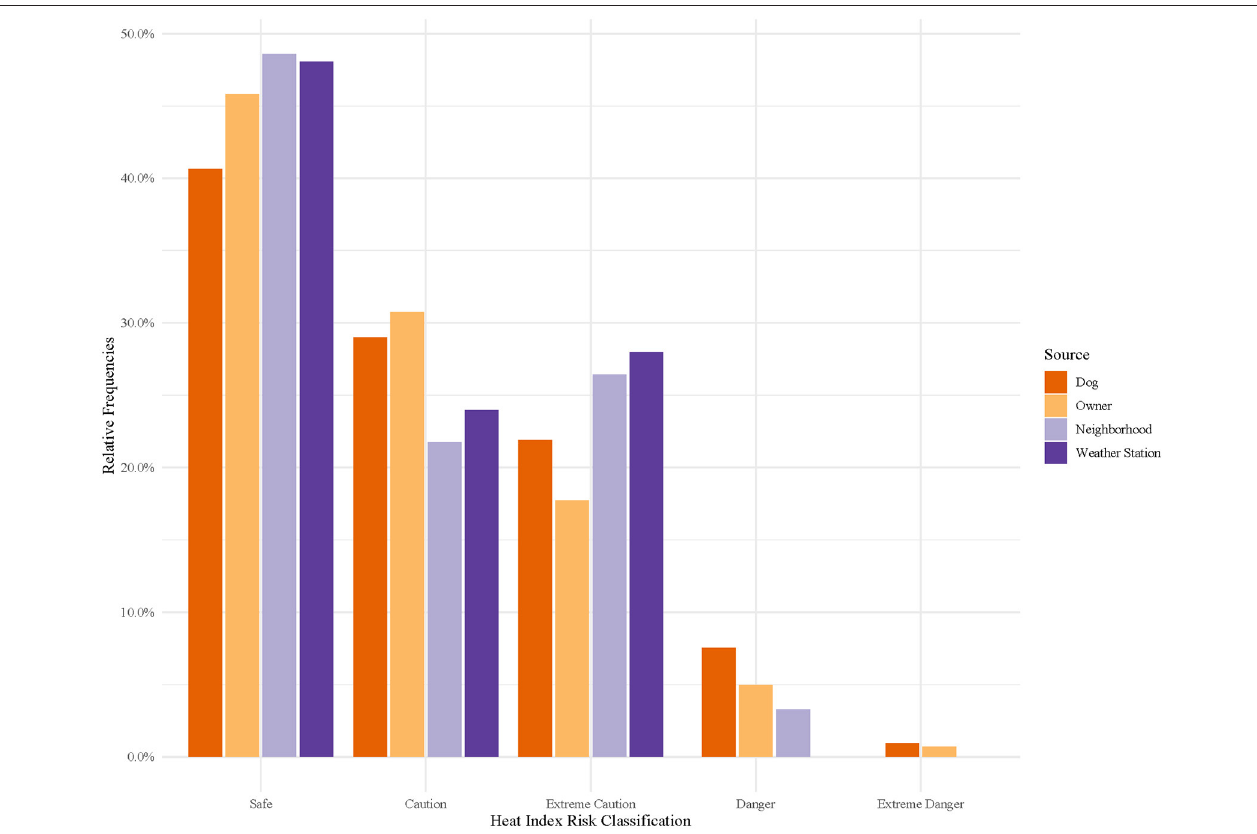
FIGURE 5 | Relative frequencies of hourly heat index risk classification calculated for canine pets’ thermometers, owners’ thermometers, neighborhood weather stations, and nearest weather station. Heat index risk classifications were determined by the National Weather Service’s designations: Safe ( < 80 ◦ F), Caution (80–90 ◦ F), Extreme Caution (90–103 ◦ F), Danger (103–124 ◦ F), and Extreme Danger ( ≥ 125 ◦ F) (